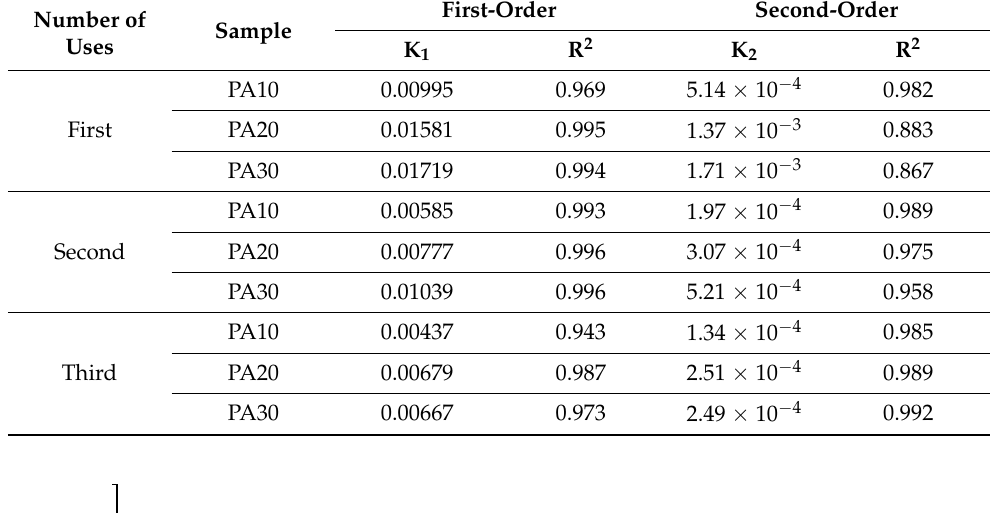
Table 5. Kinetic parameters of PA10, PA20 and PA30 samples in their repeated use.